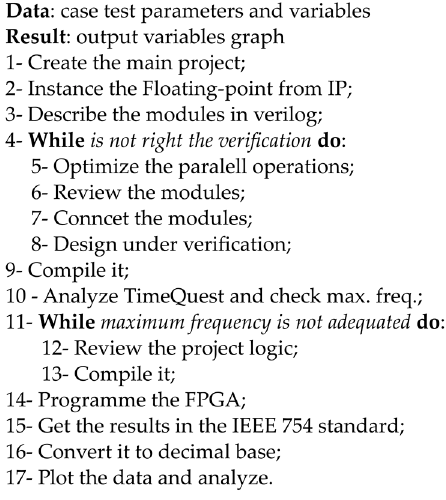
Figure 10. Pseudo-algorithm